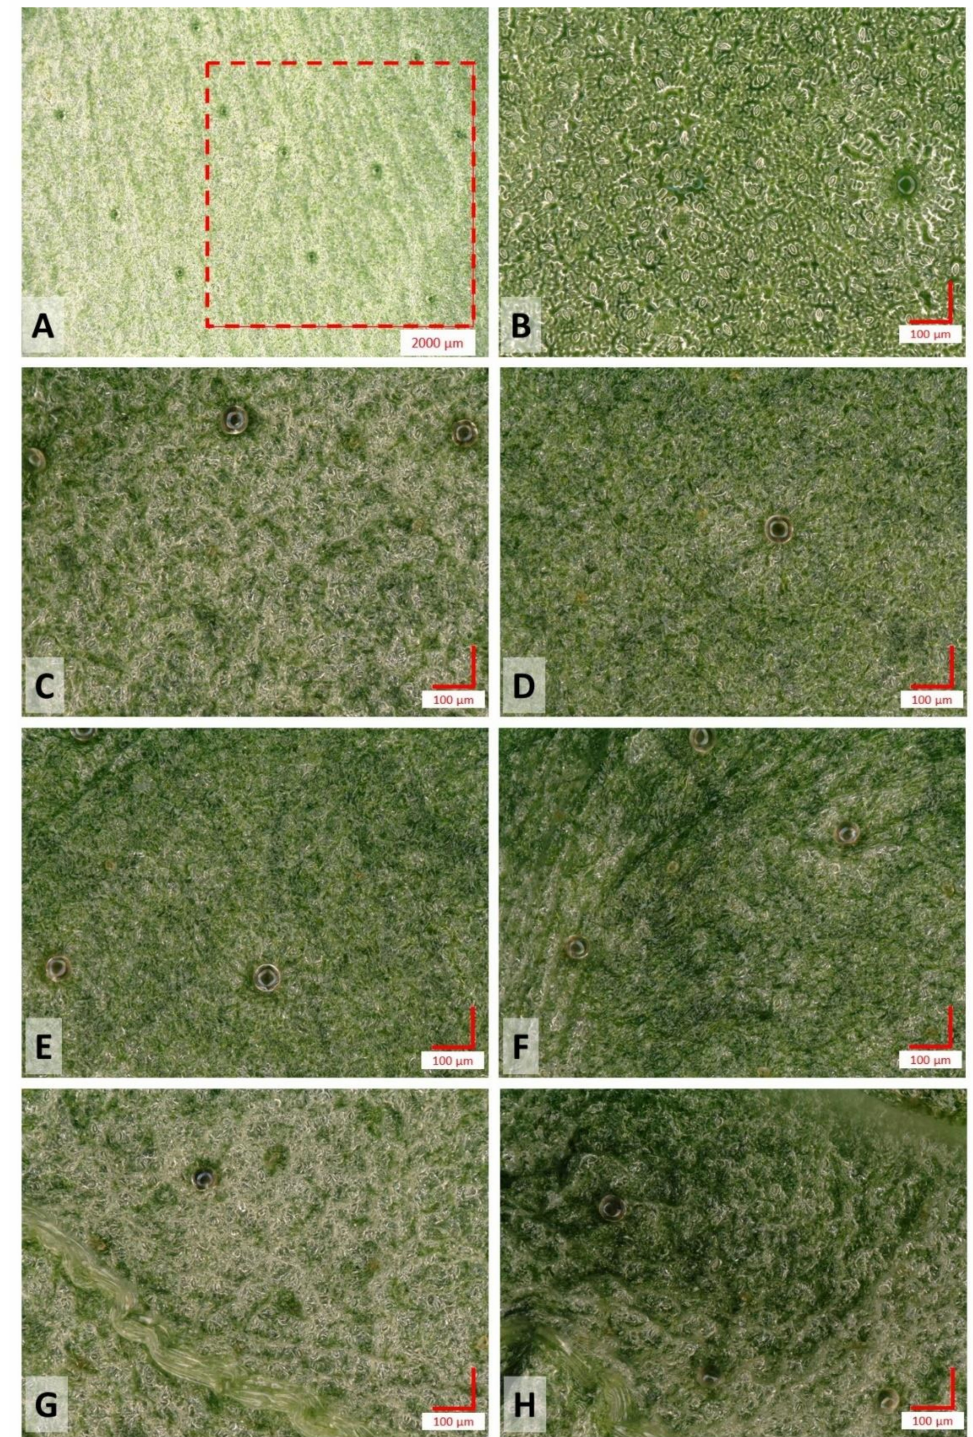
Figure 7. Representative micrographs of fresh and rehydrated Thai basil leaf samples subjected to various treatments and examined using a high-resolution optical microscope: micrograph showing the number of trichomes in a 2 mm 2 area ( A ) with a magnification during acquisition of 100 × , fresh ( B ), convective dried control ( C ), vacuum dried control ( D ), convective dried, PEF-rested ( E ), vacuum dried, PEF-rested ( F ), convective dried, control-rested ( G ), vacuum dried, control-rested ( H ). The magnification of the micrographs ( B – H ) during acquisition was 300 ×